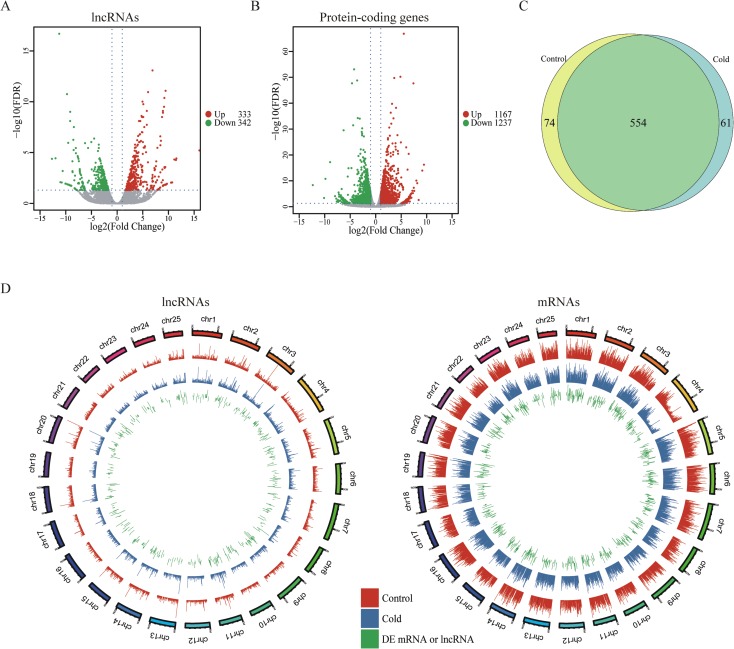
Differential expression patterns of lncRNAs between control and cold acclimated cells.(A-B) The Volcano plots of differentially expressed lncRNAs and protein-coding genes between control or cold acclimated cells, respectively. Abscissa represents log2 (fold-change), and ordinate represents -log10 (FDR). Red dots denote the significantly up-regulated lncRNAs or genes. Green dots denote the significantly down-regulated lncRNAs or genes. Blue dots denote the non-differentially expressed lncRNAs or genes. (C) Venn diagram shows the number of the differentially expressed lncRNAs expressed only in normal cultured or cold acclimated cells. (D) Distribution of mRNAs or lncRNAs along each chromosome. Red and blue represent the log-transformed FPKM values in control or cold acclimated cells, respectively. Green represents the log-transformed fold change, outward and inward bars represent up-regulated and down-regulated RNA, respectively (generated using ggbio R package).